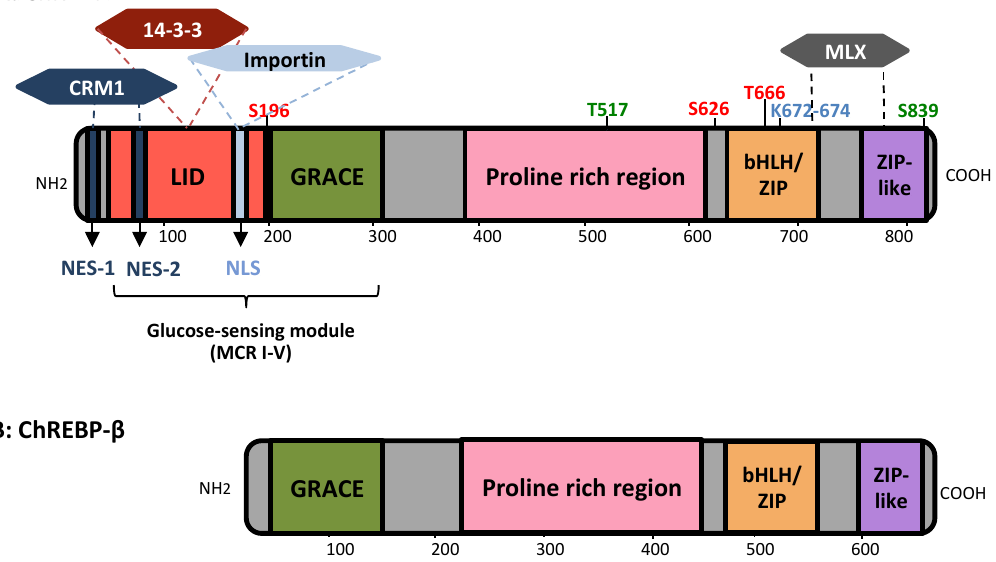
Figure 3. Representation of the structural domains of ChREBP. ( A ) The five ChREBP domains are illustrated in the boxes with an orientation bar of the number of amino acids below. The LID and GRACE domains conform the glucose-sensing module and include the MCR. The NES, NLS, the main target residues of post-translational modifications (phosphorylation in red, acetylation in blue, O-Glc-Acetylation in green) and the binding sites of some of the proteins required for the activation of ChREBP are also indicated. ( B ) The structure of ChREBP- β is analogous to ChREBP except for lacking the first 177 amino acids.